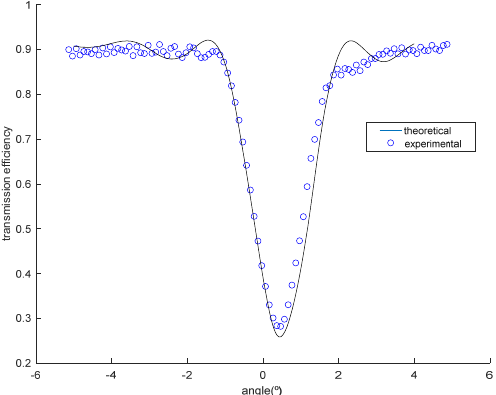
Figure 9. Transmission efficiency as a function of the angle made by the incident ray with respect to the normal of the sample for a slanted recorded grating of spatial frequency 1700 lines/mm.